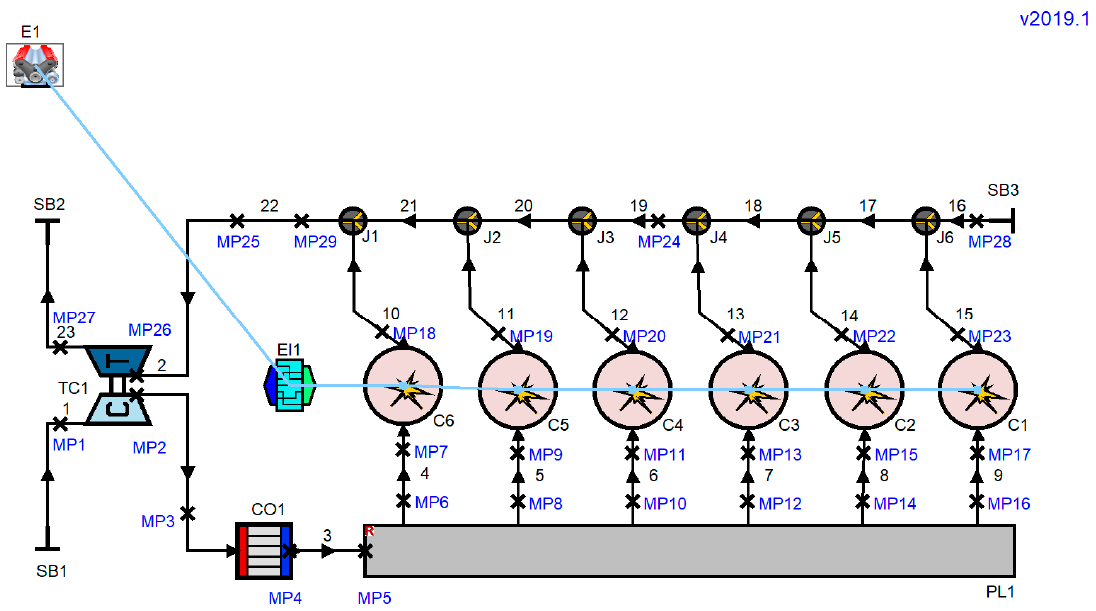
Figure 3. AVL BOOST © model for a four-stroke marine diesel Figure 3. AVL BOOST© model for a four-stroke marine diesel engine.